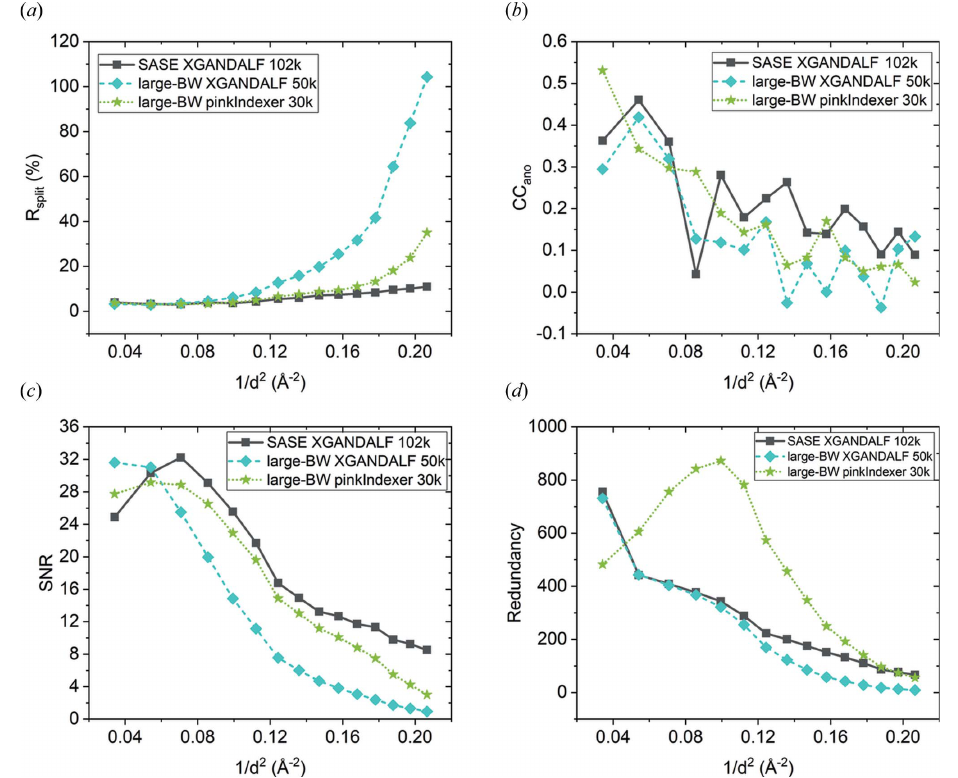
Figure 2 Comparison of data-quality indicators between the SASE and large-BW thaumatin data sets indexed by XGANDALF and pinkIndexer calculated with the minimal number of indexed images required for automatic de novo structure determination up to a resolution limit of 2.2 A˚ . ( a ) R split , ( b ) CC ano , ( c ) SNR and ( d ) redundancy of individual reflections as a function of